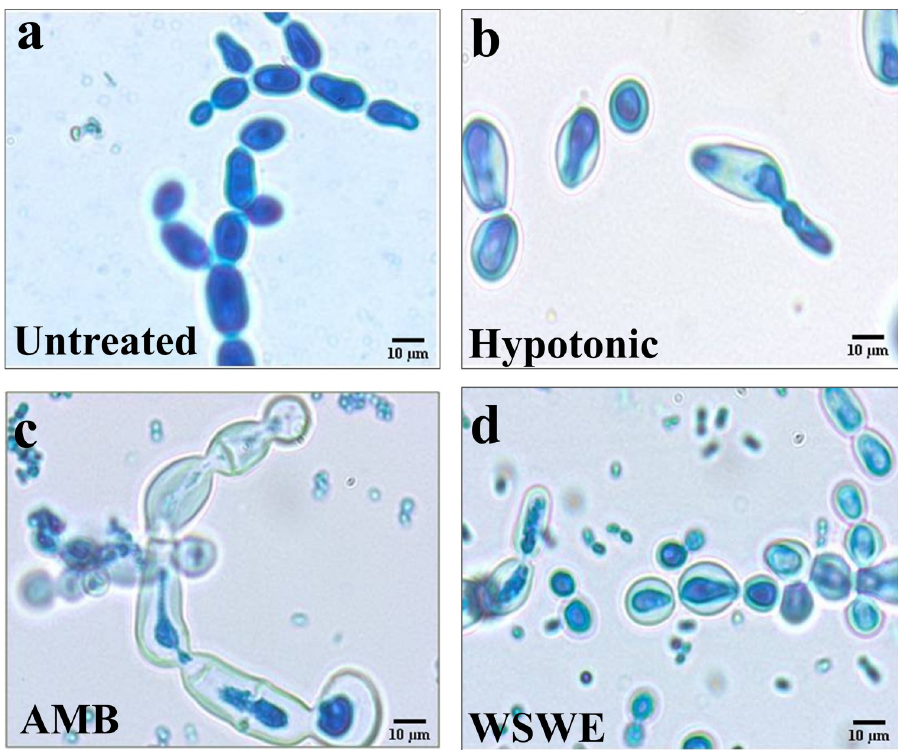
Fig 6. Micromorphological impact of WSWE treatment on S . globosa cells. Micrographs showing trypan blue lactophenol cotton blue stained untreated (a), hypotonically treated protoplasted (b), amphotericin B (AMB) treated (c) and WSWE treated (d) S . globosa